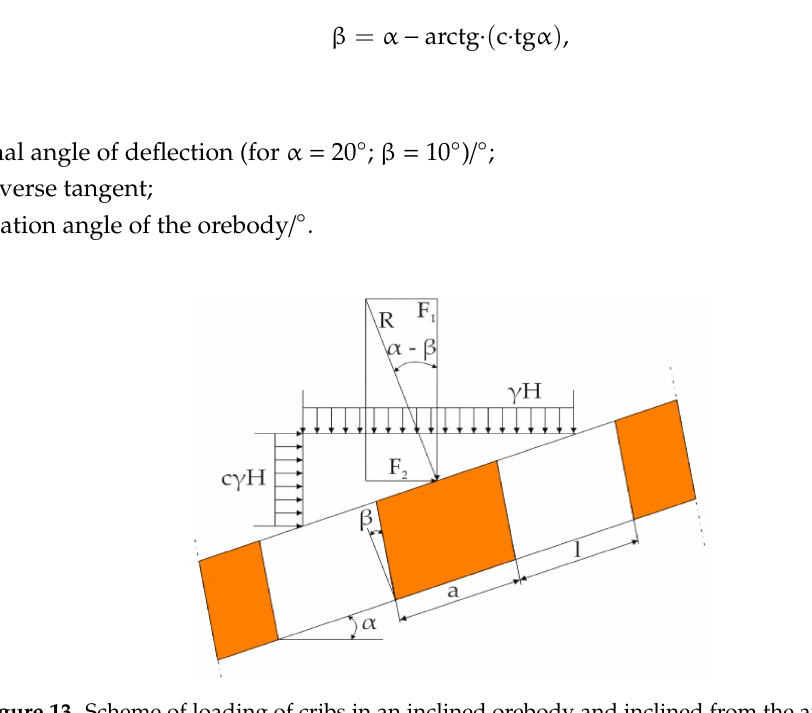
Figure 13. Scheme of loading of cribs in an inclined orebody and inclined from the axis of